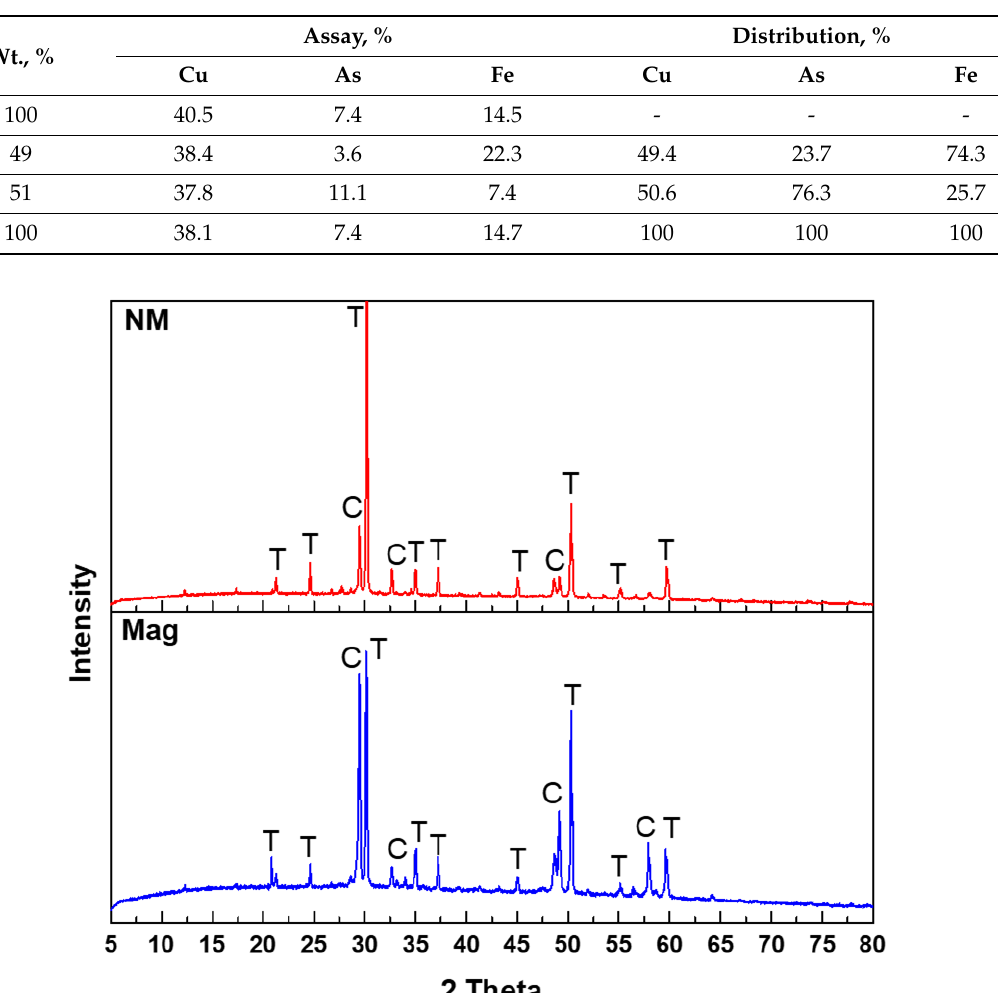
Figure 6. XRD patterns for magnetic and nonmagnetic fraction, C for chalcopyrite, and T for ten-